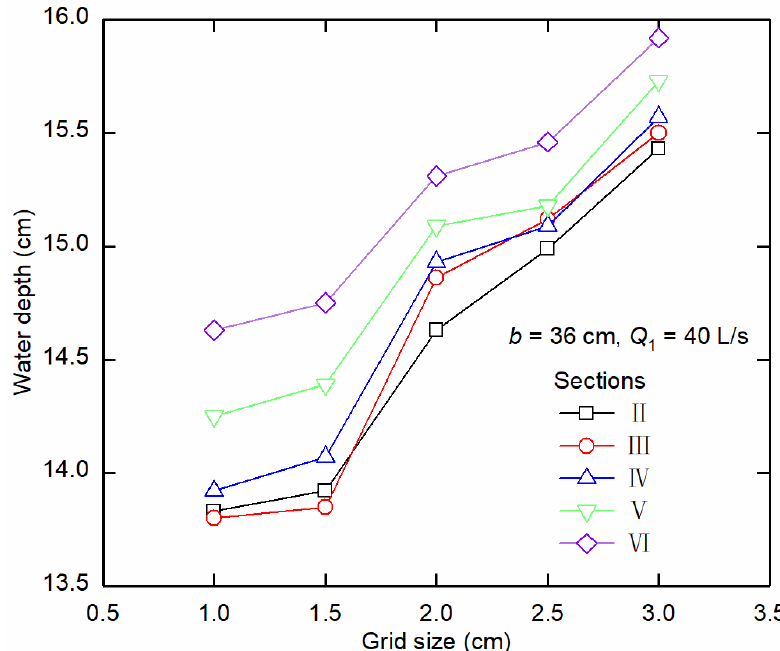
Figure 3. Grid independence test. Note: b is the branch channel width and Q 1 is flow discharge in the main channel. Table 1. Analysis of the relative error of water depth in different sections at the flow rate of 40 L/s and the branch channel width of 36